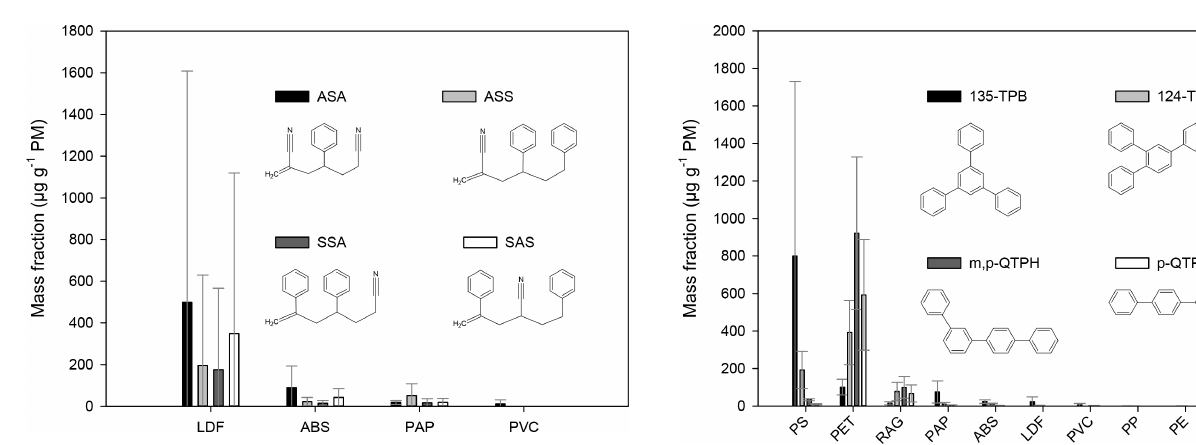
Figure 4. The mass fraction (in units ofµgg − 1 PM − 1 ) of triph- enylbenzenes and quaterphenyls from the burning of different waste types. The error bars represent the standard deviation of the EF data obtained for a given type of waste under different burning condi-